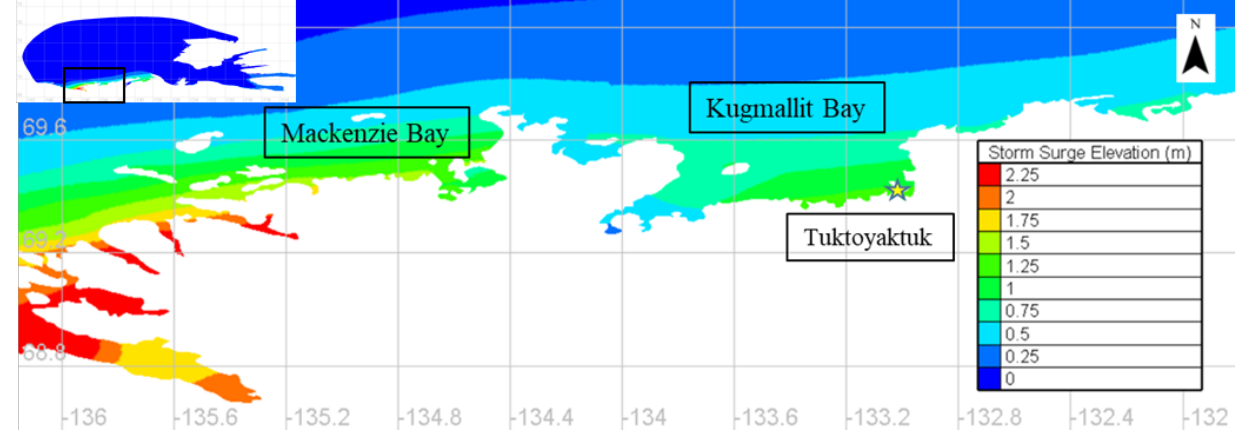
Figure 13. Hindcast of the 23 August 1986 storm surge event.